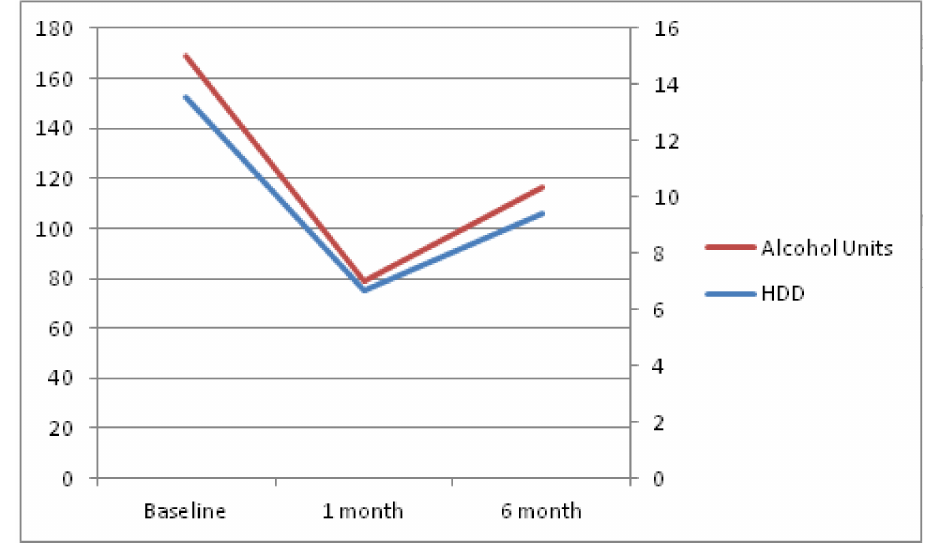
Figure 1. The change over time of study outcomes according to intention-to-treat analysis. The left axis shows alcohol units over the last 4 weeks. The right axis shows heavy-drinking days over the last 4 weeks. HDD: heavy drinking days.